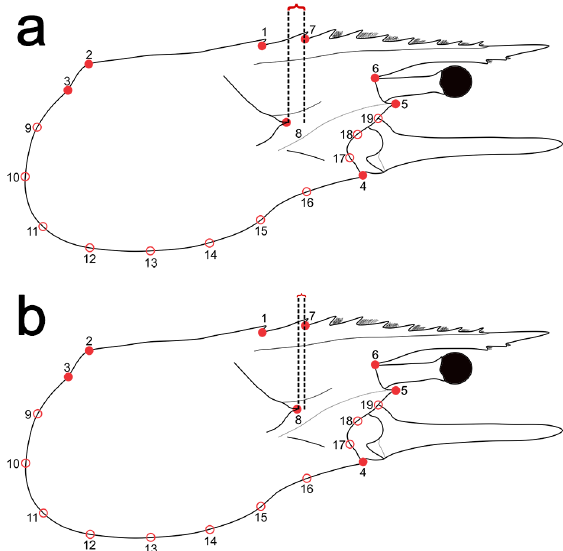
Figure 4. Cephalothorax right profile of Litopenaeus illustrating the difference in the position of the base of the first rostral tooth in relation to the tip of the hepatic spine between Litopenaeus schmitti (a) and Litopenaeus vannamei